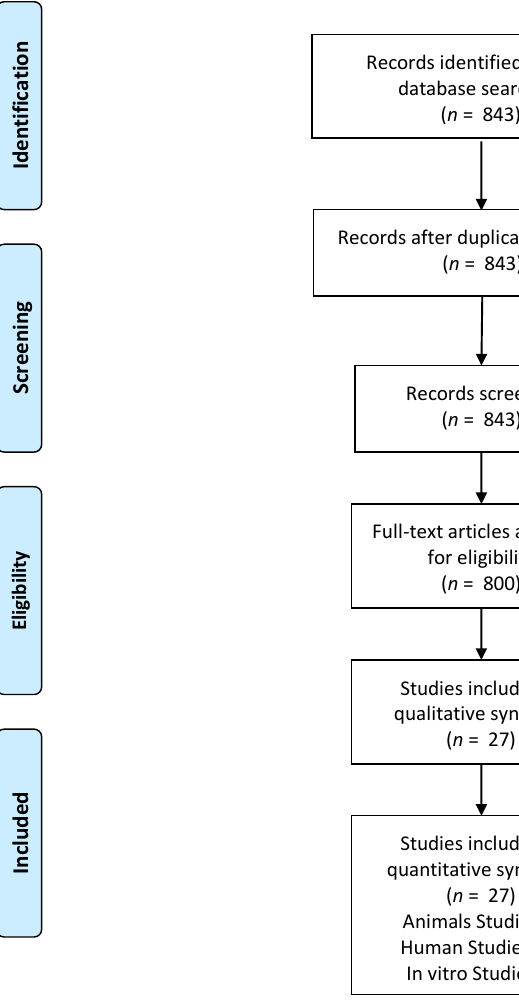
Figure 1. Flow diagram (PRISMA format) of the screening and selection process. Table 1. Summary of the in vitro studies included for the qualitative